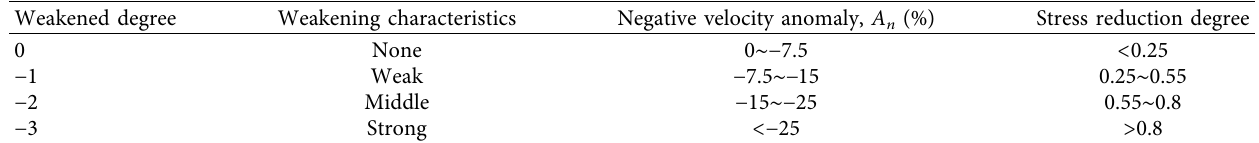
Table 7: Relation between negative velocity anomalies and coal burst risk level.